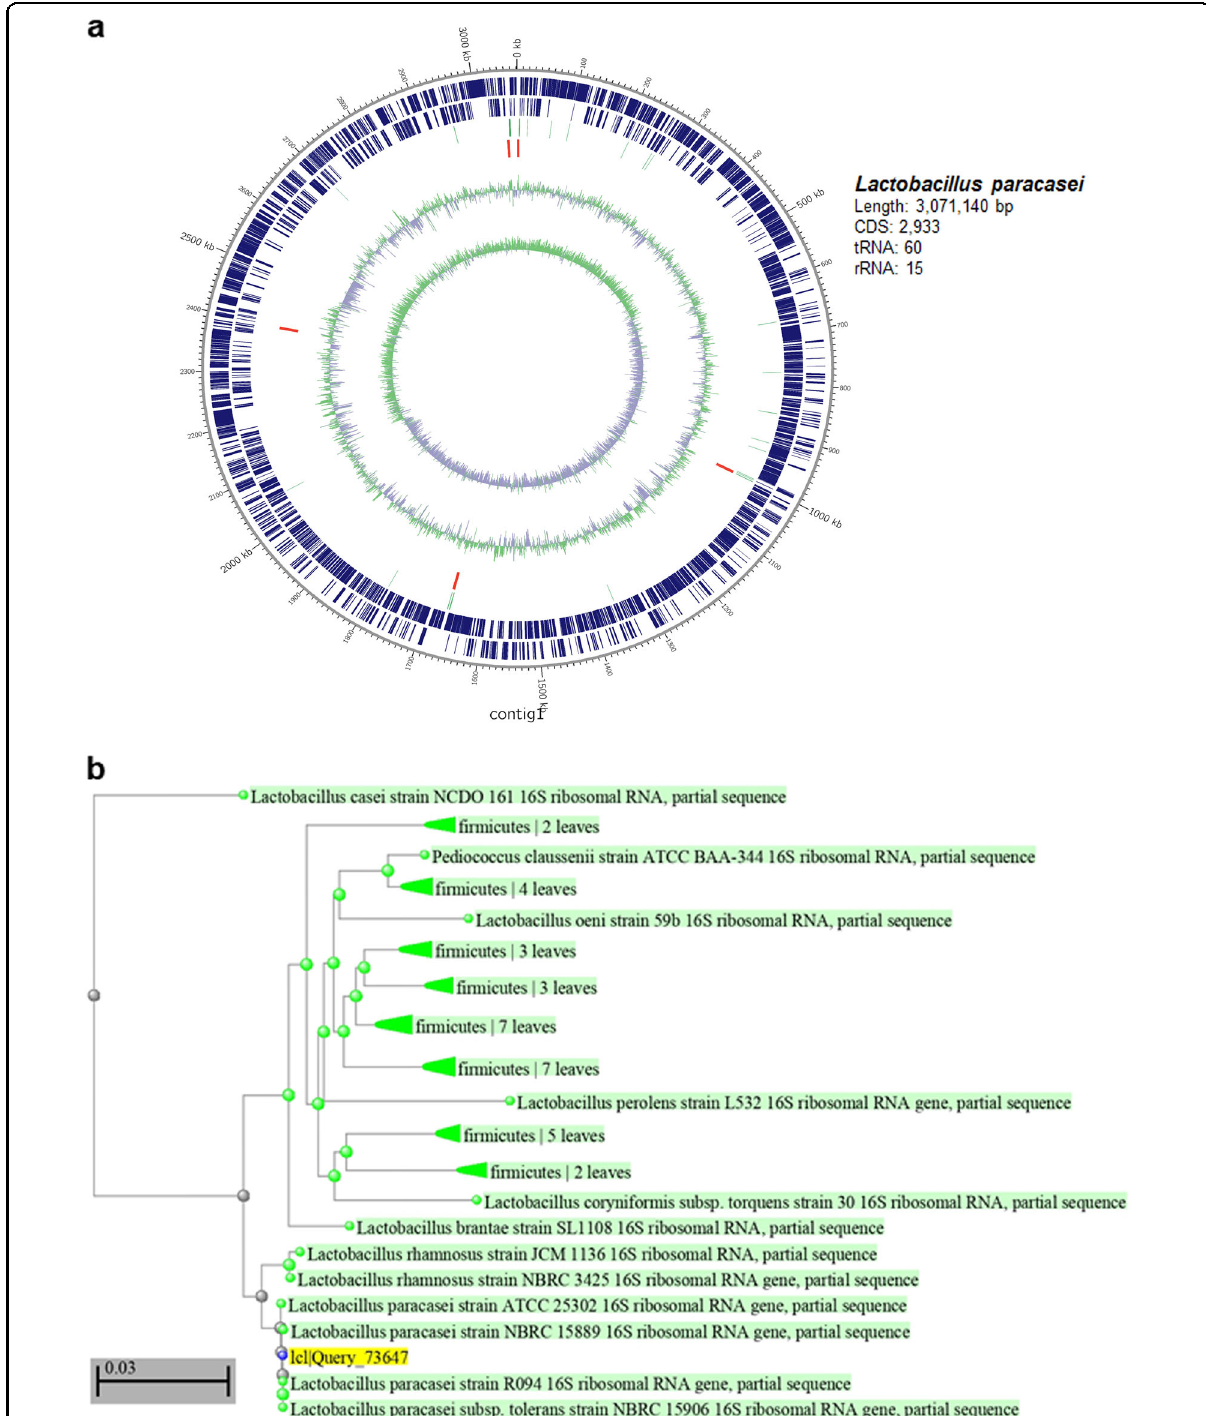
Fig. 1 Genomic characteristics of L. paracasei . a Circular map of L. paracasei . The following factors are shown from the outside to the center: CDS (coding sequence) on the forward strand, CDS on the reverse strand, tRNA, rRNA, GC content, and GC skew. b Phylogenetic diagram of L. paracasei